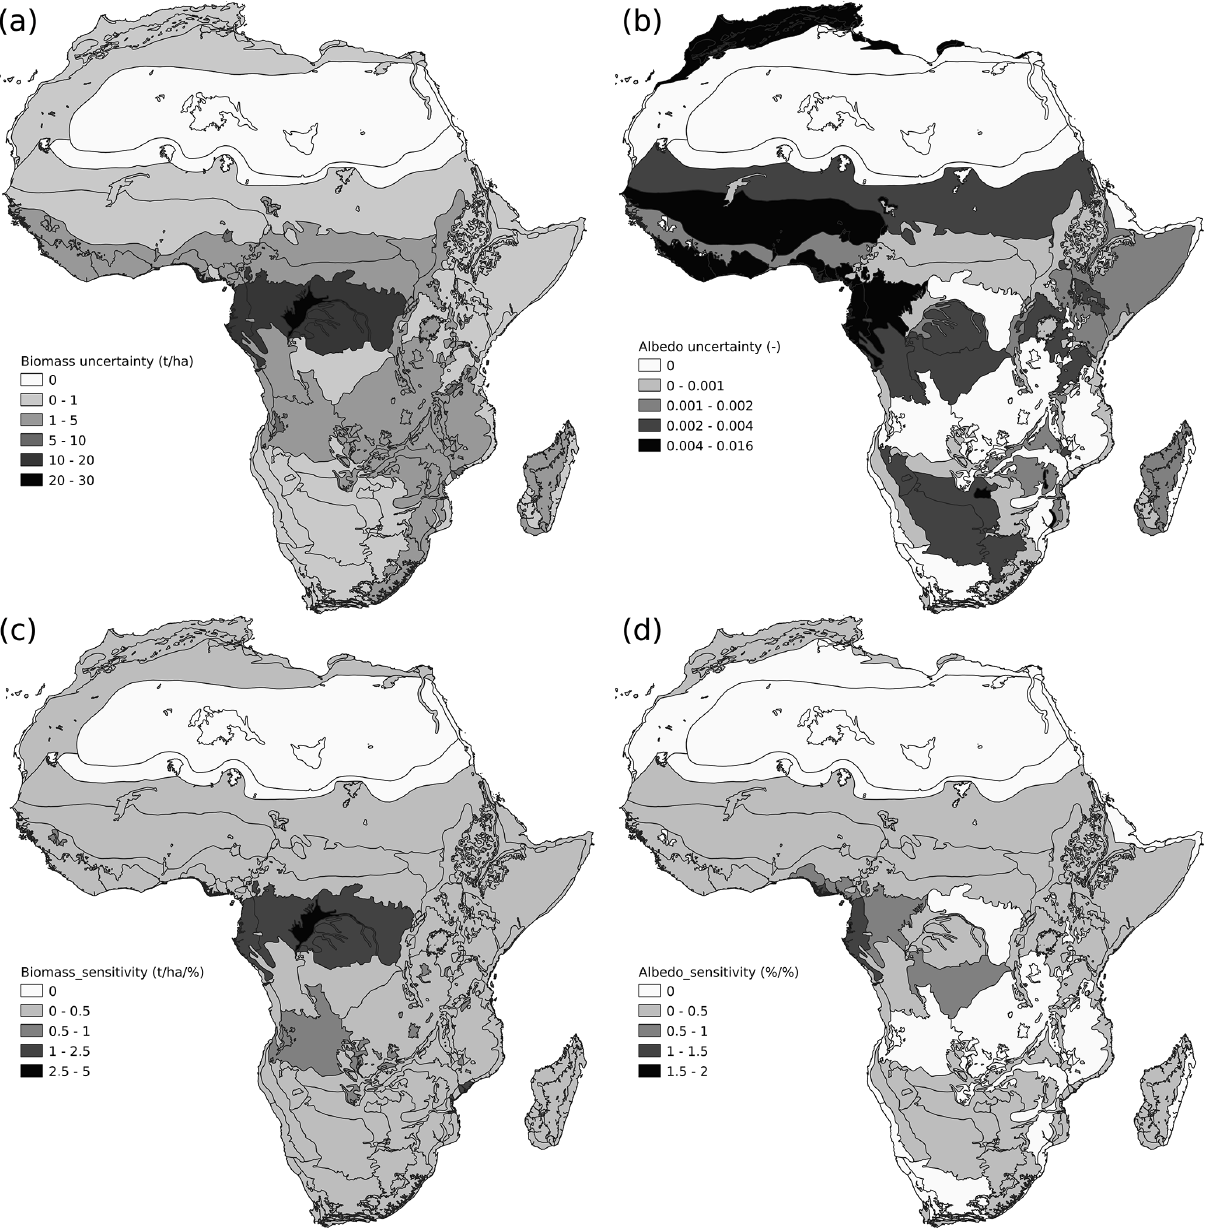
Figure 4. Confident interval propagation of the PFTs maps into AGB and visible albedo simulated by ORCHIDEE. (a) Uncertainty propa- gation into AGB and (b) uncertainty propagation into visible albedo from the difference between the 2.5% and the 97.5% PFT map defined by the optimization procedure. Uncertainty propagation index (Eq. 16) for AGB (c) and visible albedo (d)